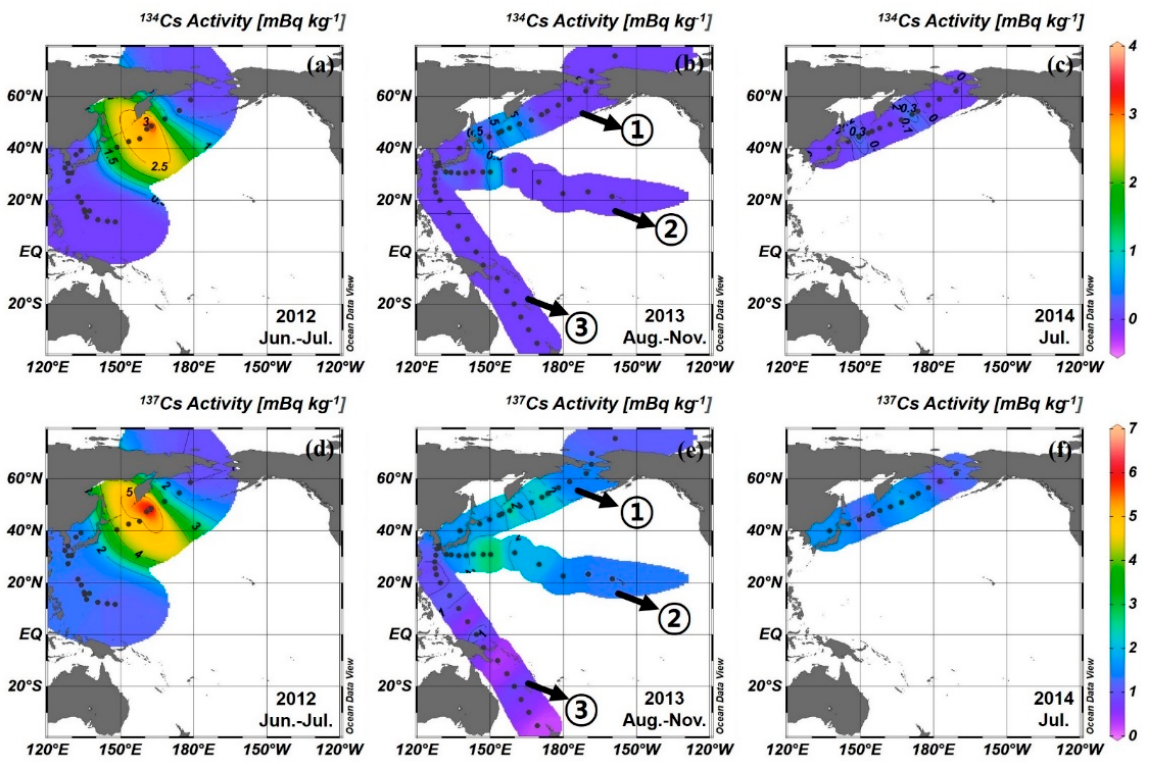
Figure 5. The sectional distributions of radiocesium, 134 Cs (upper panel, ( a – c )); and 137 Cs (lower panel, ( d – f )), from three (#1 to #3) sections in the North Pacific, 2012–2014.